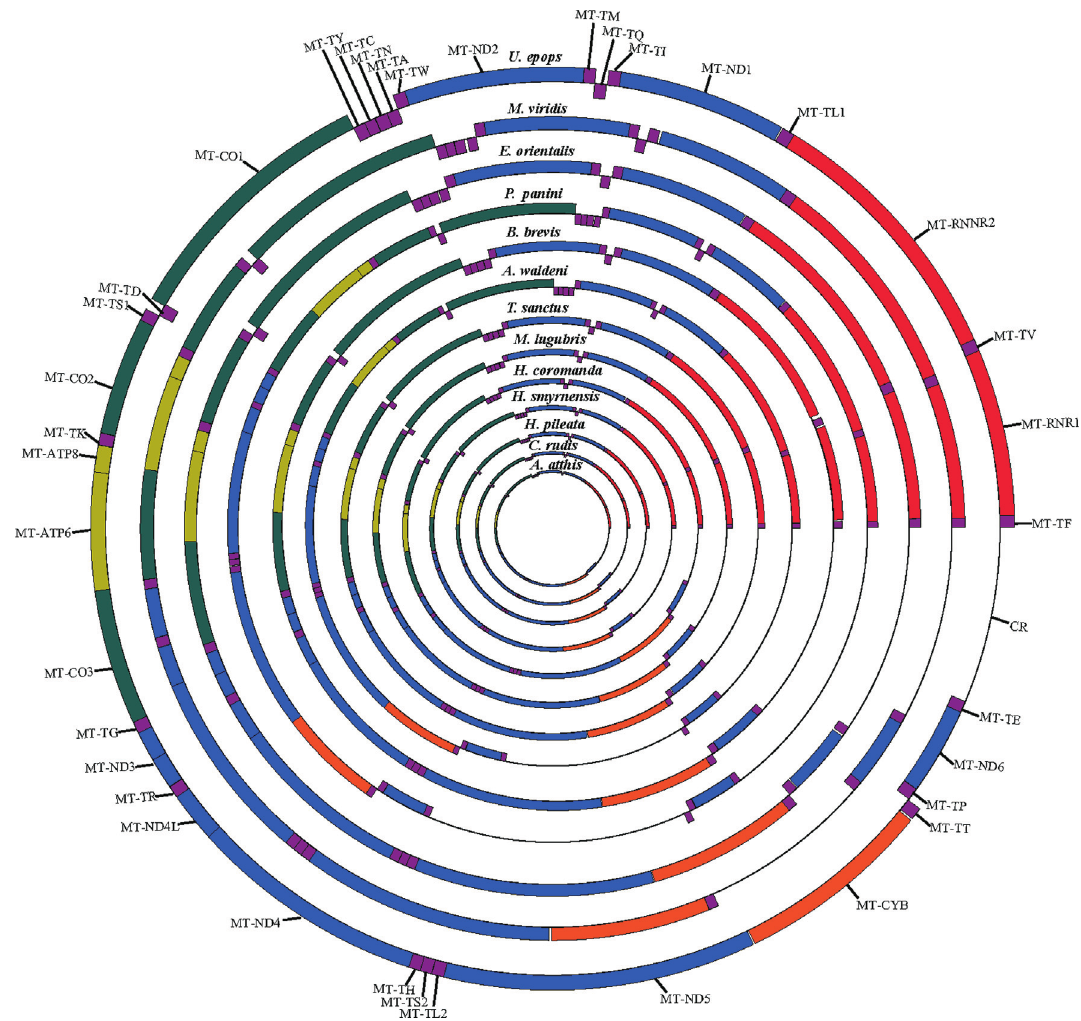
Figure 1 - Comparative circular map showing the genome organizations of 13 Coraciiform mitogenomes listed in Table